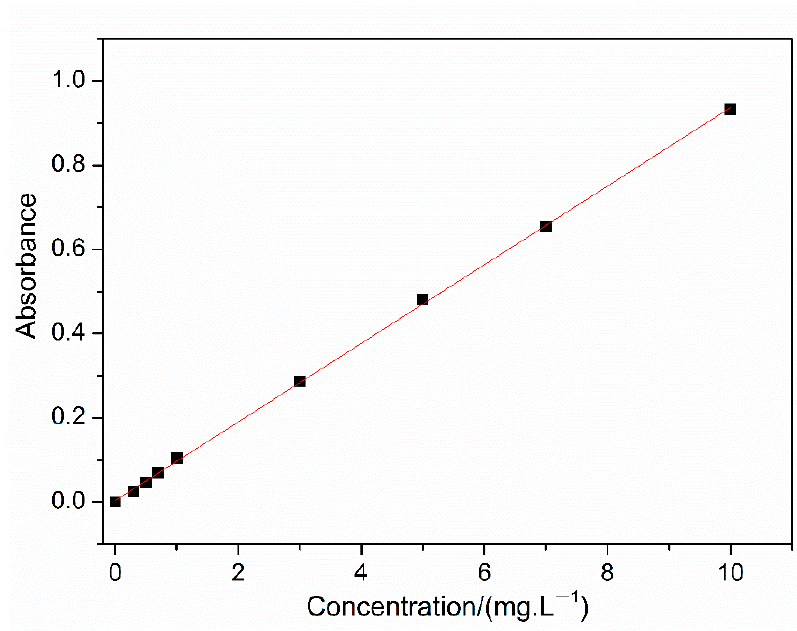
Figure 3. Plot of standard curve.